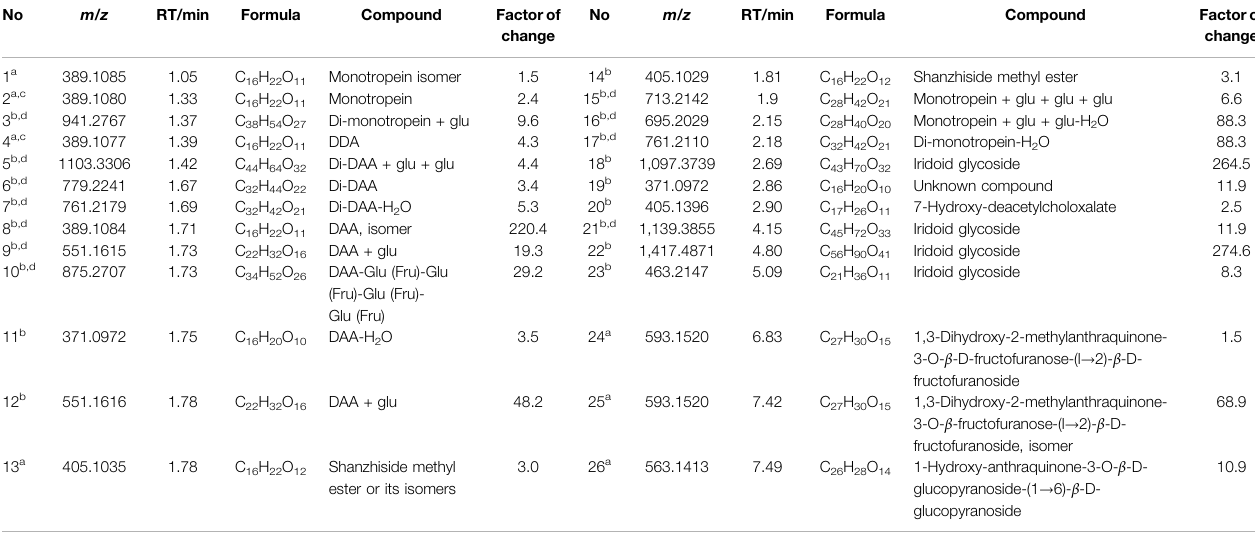
TABLE 2 | Chemical components with larger difference in content between the samples of MOR and PMOR (Acquity BEH column). No m/z RT/min Formula Compound Factorof